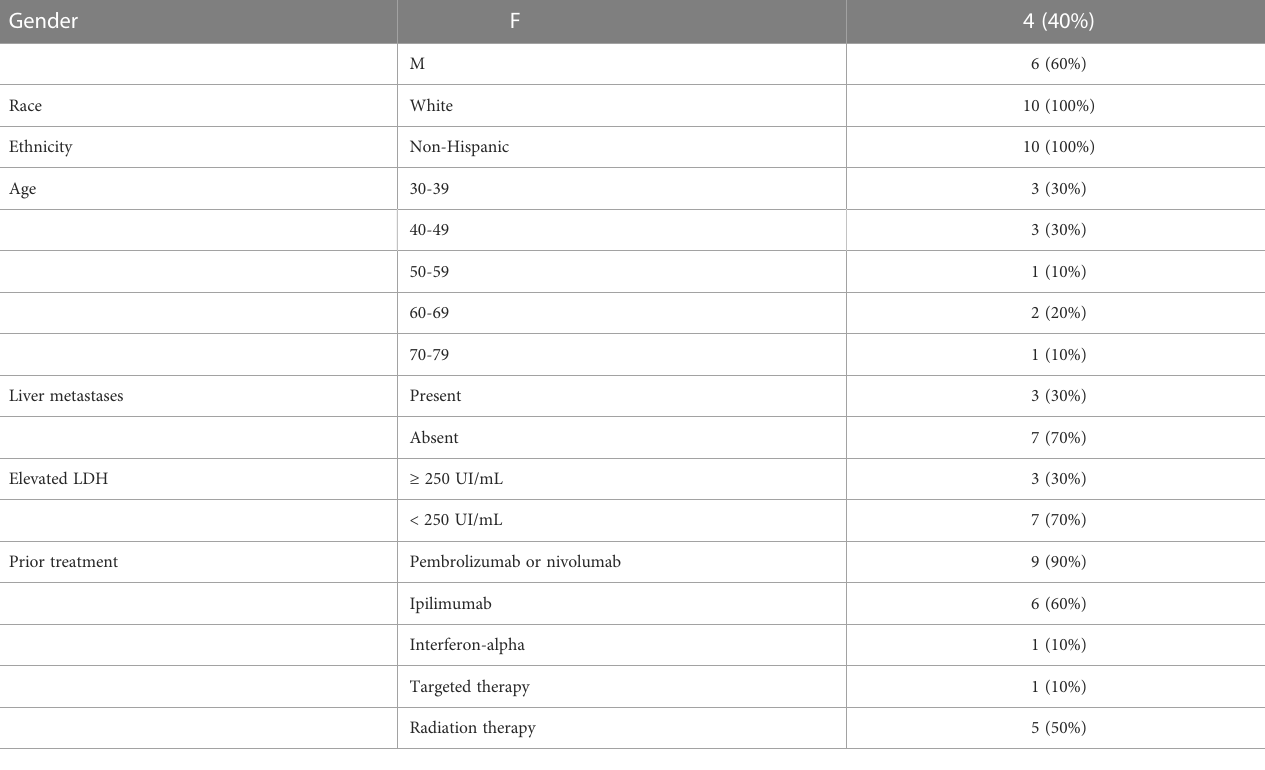
TABLE 1 Baseline characteristics of 10 patients who enrolled on the study.